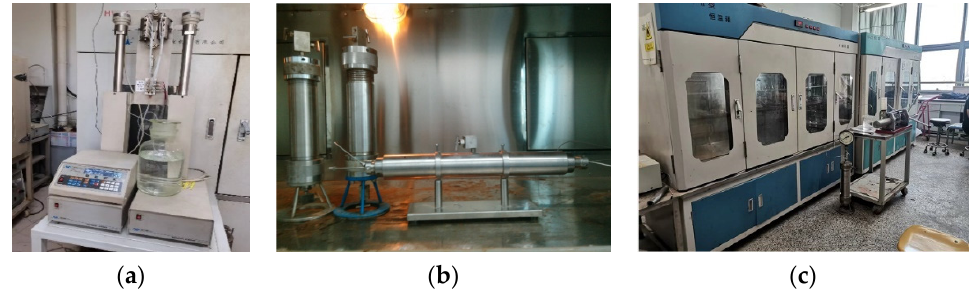
Figure 2. Experimental apparatus. ( a ) Pump, ( b ) container and core holder, ( c ) calorstat. The injection rate can be controlled by the pump with the range of 0.001 to 60 mL/min. The back pressure valve is opened only when the outlet pressure exceeds the back pressure, which represents the minimum outflow pressure. The pressure sensors are set both at the beginning and the end of the core holder to test the inlet pressure and outlet pressure, respectively.